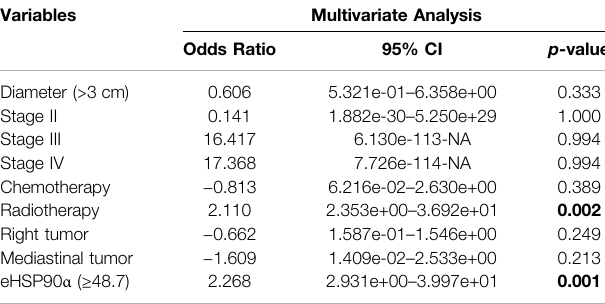
TABLE 4 | Multivariate logistic regression analysis of in fl uencing results of SCLC chemotherapy. Variables Multivariate